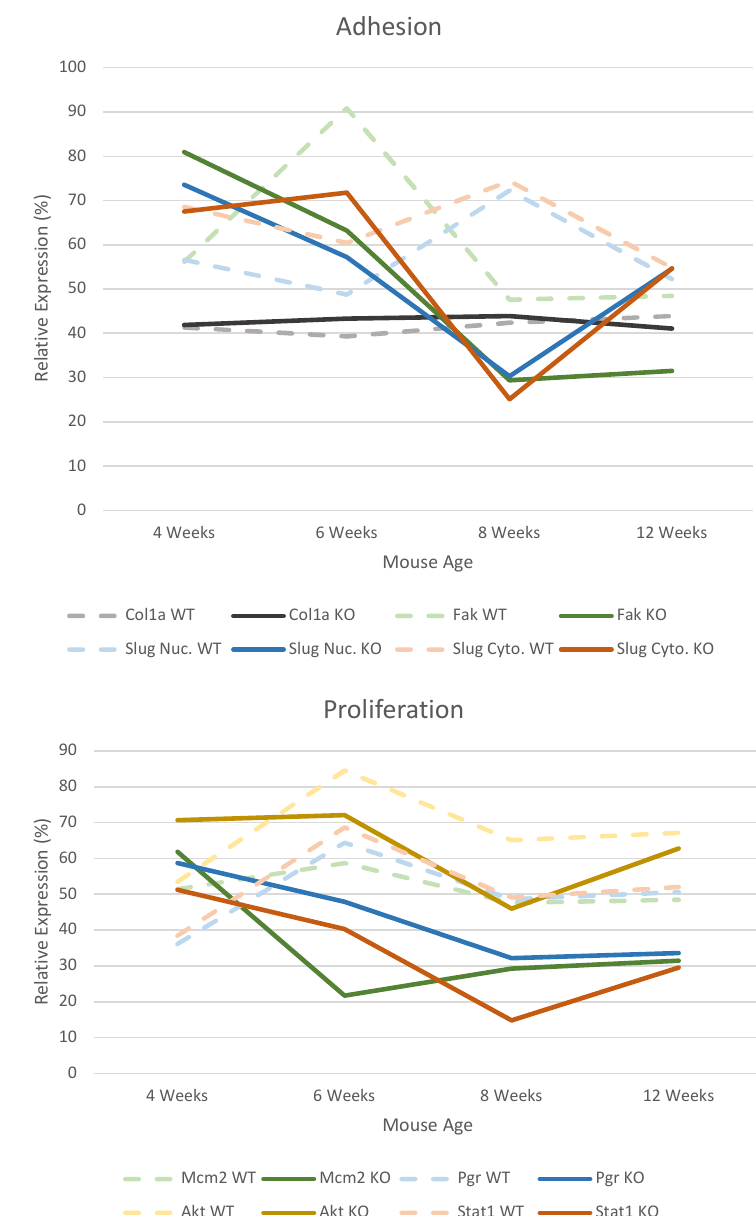
Figure 8. The expression patterns of the proteins analysed show alternative peaks of expression in the Csmd1 KO mice compared to the WT. The expression levels across all time points (4–12 weeks) are shown to demonstrate how the specific expression of the proteins changes over puberty and also how the patterns vary between the WT and KO mice. ( A ) Graph showing the proteins associated with regulating cell adhesion. ( B ) Graph showing the proteins associated with regulating cell proliferation. In both graphs clear alternative peaks can be observed between the WT, peak of expression commonly at 6 weeks, and the KO mice, peak of expression commonly at 4